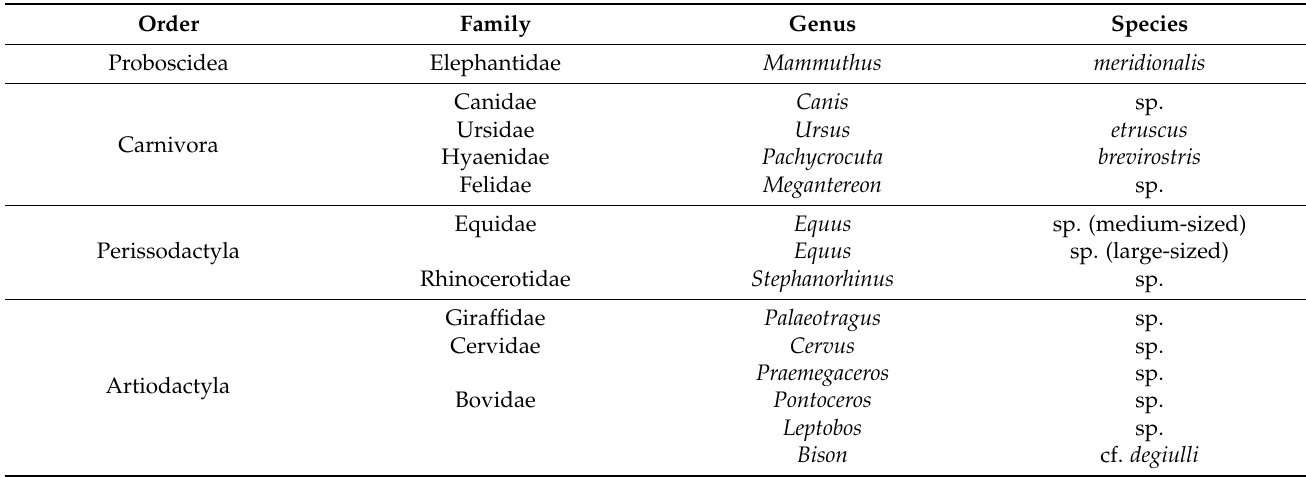
Figure 4. ( a ) Stratigraphic log (modified from [33] ) of the Tsiotra Vryssi section with location of the samples for magneto- stratigraphy and experiments for rock magnetism, and for cosmogenic radionuclides dating; ( b ) Latitude of the virtual geomagnetic poles (VGP) with interpreted magnetostratigraphy (black is normal polarity, white reverse polarity); ( c ) Magnetic susceptibility κ . Table 1. Preliminary faunal list of the large mammals from Tsiotra Vryssi (excavation seasons 2014–2019). Faunal list updated from [21] , based on [34 – 36] and unpublished data.